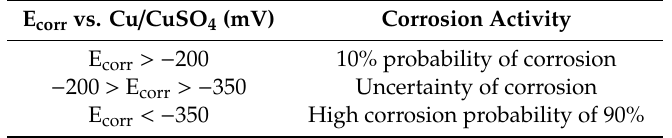
Table 4. Measured half-cell corrosion potential (E corr ) versus a Cu / CuSO4 in reinforcement concrete.